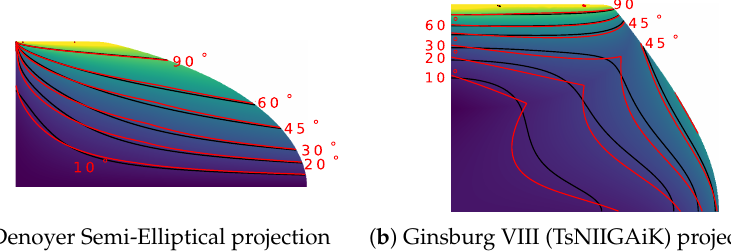
Figure 16. Distributions and contours (in red) of the FWD–GCA-based angular metric for evaluating more map projections without inverse